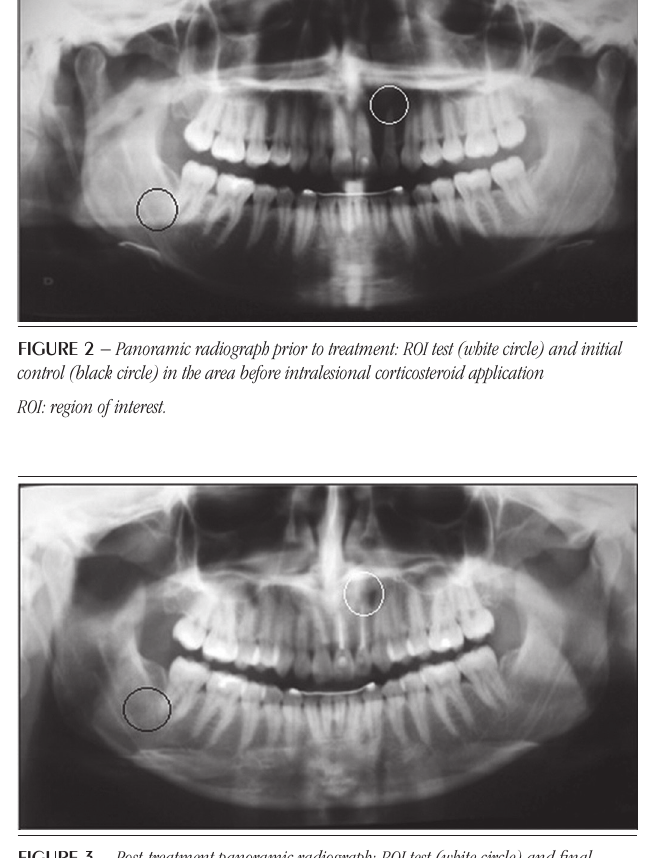
figurE 3 − Post-treatment panoramic radiograph: ROI test (white circle) and final control (black circle) after the protocol of intralesional corticosteroid application ROI: region of